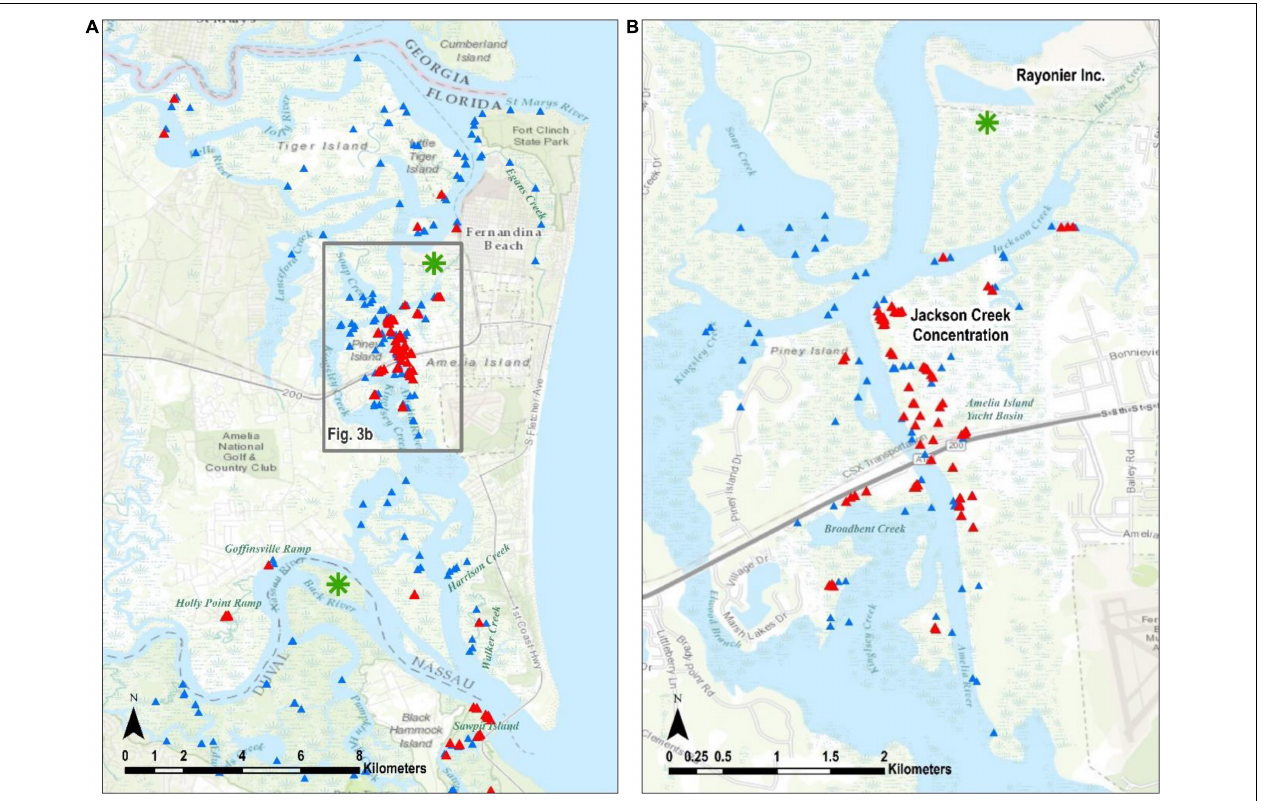
FIGURE 3 | The Nassau Terrapin evidence. All records are indicated in (A) along with the Jackson Creek concentration in the box. The Jackson Creek concentration is highlighted in (B) . Green asterisks are places where Terrapin evidence was recorded before the current study, and they are discussed in the body of the paper. Triangles as defined in Figure 2